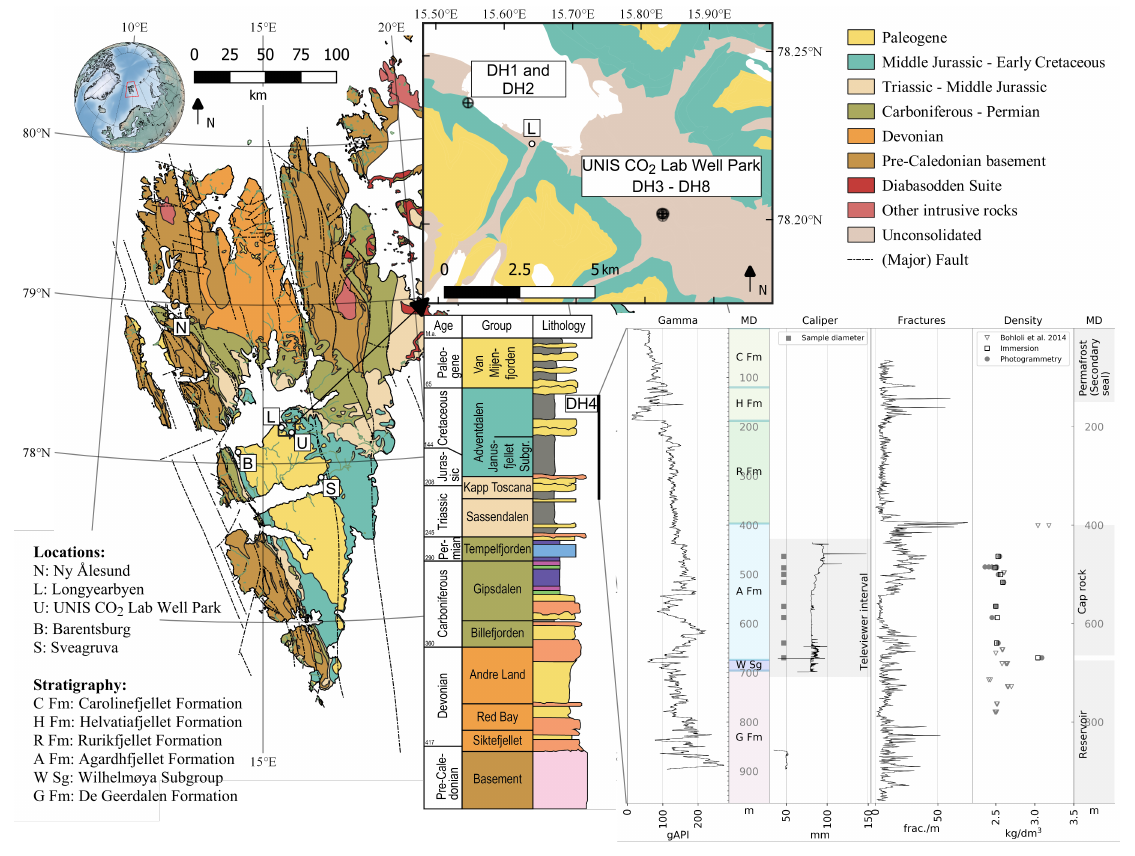
Figure 1. Location and geological map of Svalbard and its main settlements. The inset shows a close-up of Longyearbyen, with the UNIS CO 2 Lab Well Park. The interval covered by DH4 is indicated on the stratigraphic column, and a selection of available wireline logging, the televiewer interval, and available core-density data are shown. The fracture track is an image-based interpretation from Braathen et al. [30], and includes drilling-induced fractures. The stratigraphic column is based on an unpublished figure by Arild Andresen (UiO). Geological map data provided by the Norwegian Polar